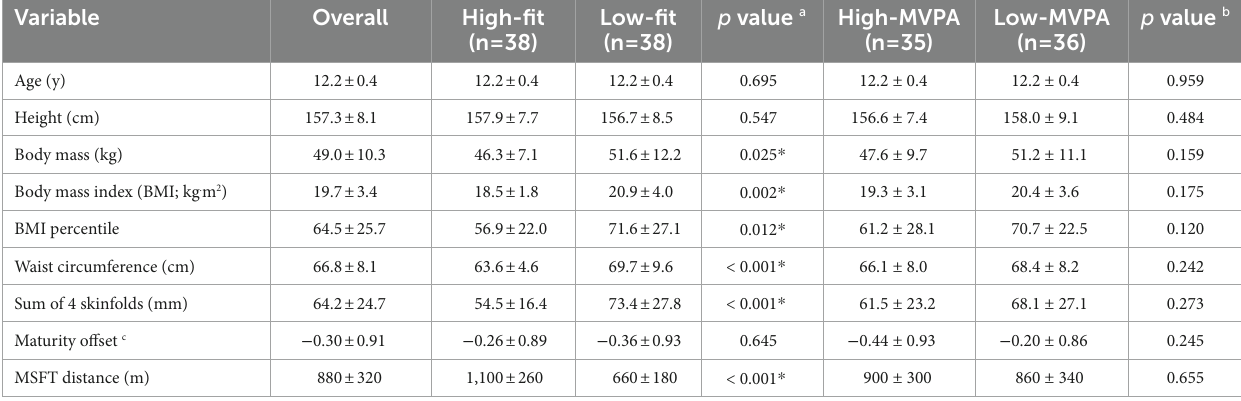
TABLE 1 Participant characteristics for the group overall, as well as for the high-and low-fit groups, and high and low MVPA groups.